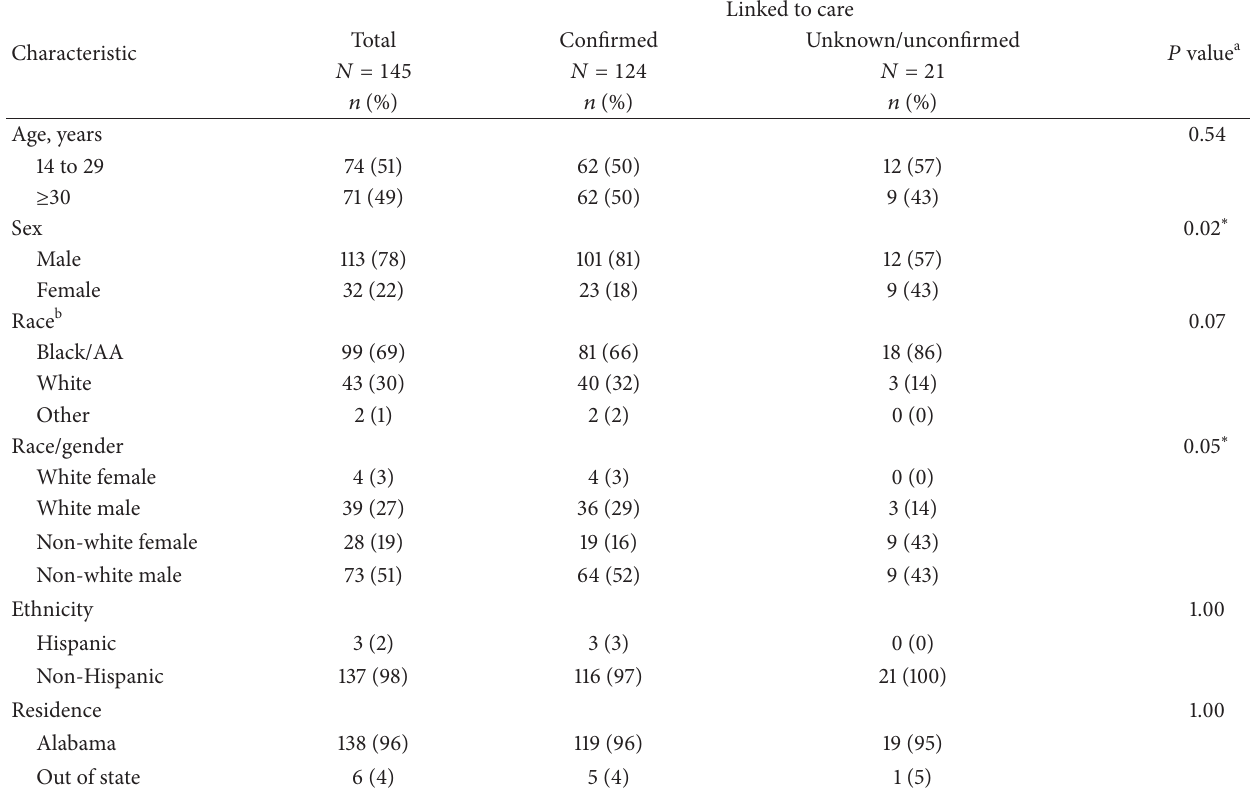
Table 5: Sociodemographic characteristics of clients who presented for HIV POC testing by linkage, AL, 2007–2012.